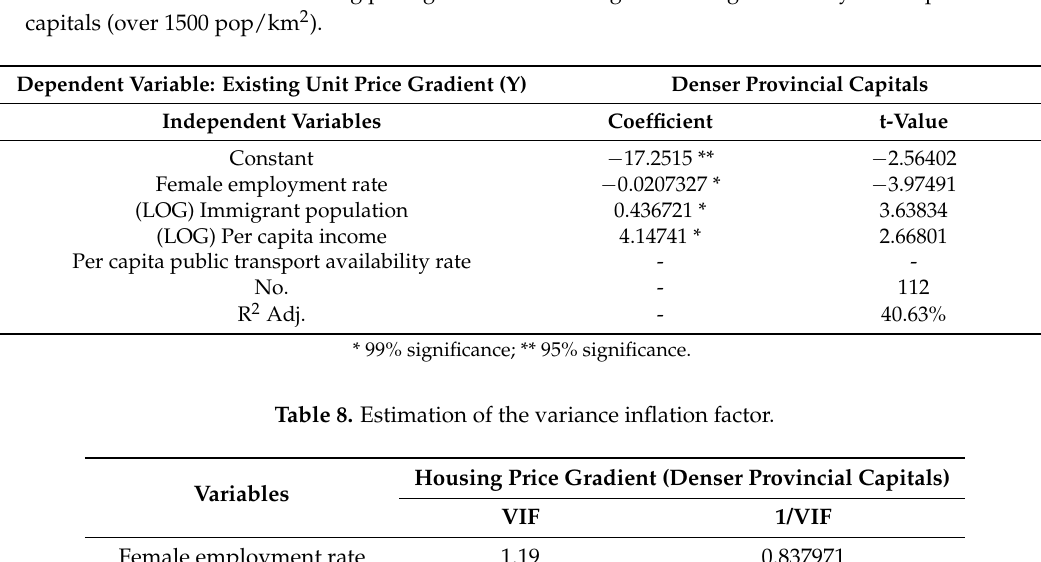
Table 7. Estimation of the housing price gradient for existing units in higher-density Italian provincial capitals (over 1500 pop/km 2 ).